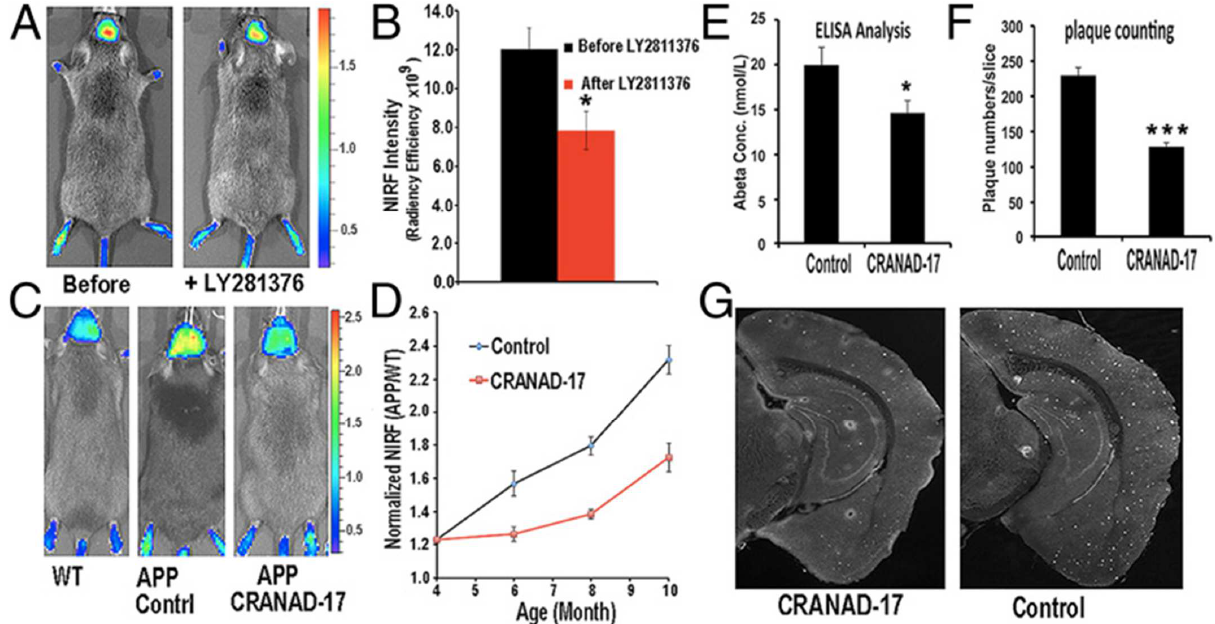
Figure 10. CRANAD-3 for detecting therapeutic effects with BACE-1 inhibitor. ( A ) Images in APP/PS1 mice with CRANAD-3 before and after treatment with LY2811376. ( B ) Quantitative analysis of the imaging in A (n = 4). ( C ) Representative images of 4-month-old APP/PS1 mice treated with CRANAD-17 for six months. ( D ) Quantitative analysis of the imaging in C (n = 5). ( E ) ELISA analysis of total Aβ40 from brain extracts. ( F ) Analysis of plaque counting. ( G ) Representative histological staining with thioflavin S. (Left) CRANAD-17–treated mouse. (Right) Control. * p < 0.05, *** p < 0.005. Reprinted with permission from [53] . Copyright 2015 PNAS.